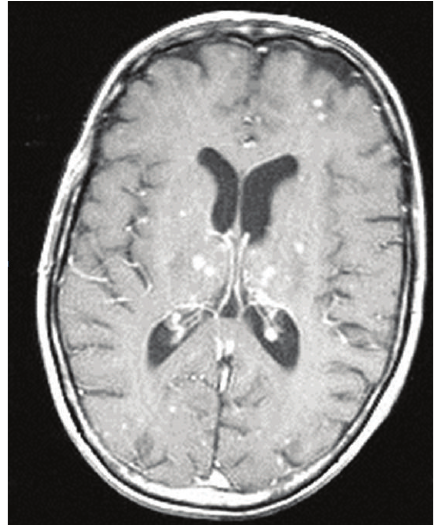
Figure 2: MRI Brain with and without contrast: T1 axial postcon- trast image showing diffuse nodule enhancement, most pronounced in the thalamic regions and basal